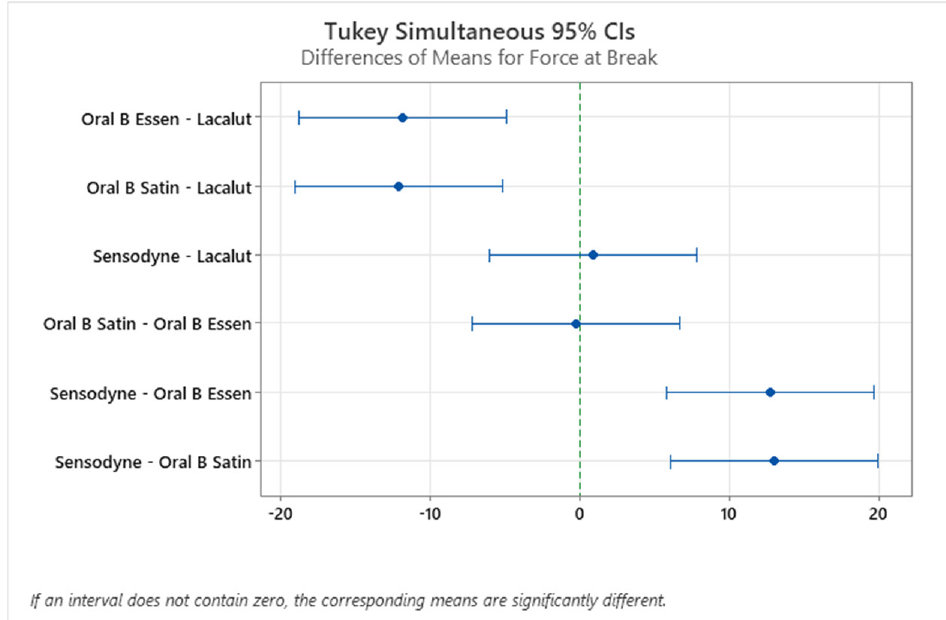
Figure 8. Differences of means for force at break, Tukey HSD test.